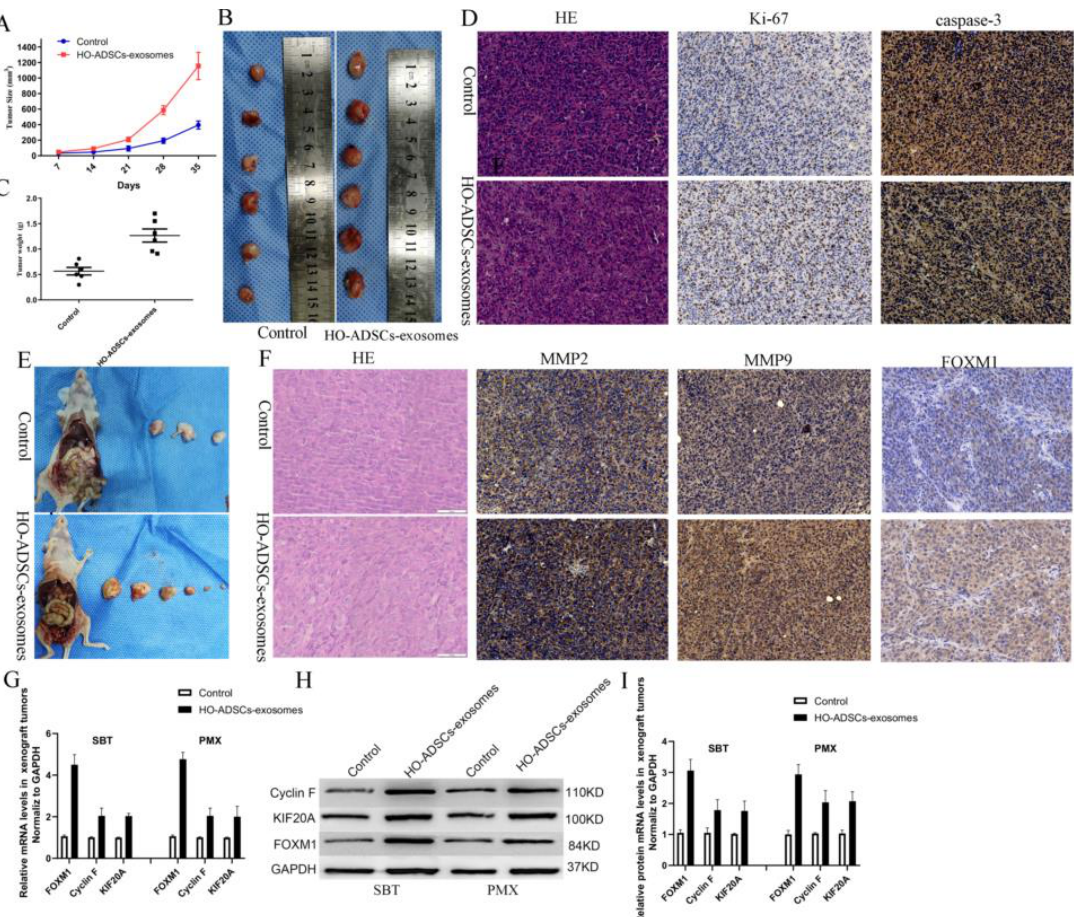
Figure 8. HO-ADSC exosomes promoted EOC tumorigenesis and progression in vivo. ( A ). The tumor growth curve of subcutaneous ovarian xenografts in mice. ( B ). Representative images of subcutaneous ovarian xenografts in mice. ( C ). Weight of subcutaneous ovarian xenografts in mice. ( D ). Representative HE staining and IHC staining for Ki-67 and caspase-3 in subcutaneous xenograft tumor tissues. ( E ). Representative images of peritoneal tumor nodules in mice. ( F ). Representative HE and IHC staining for MMP2, MMP9, and FOXM1 in peritoneal metastatic xenograft tumor tissues. ( G – I ). Cyclin F and KIF20A expression in peritoneal metastatic xenograft tumor tissues was determined by W estern blot and qRT‒PCR analysis. * p < 0.05, n = 3.